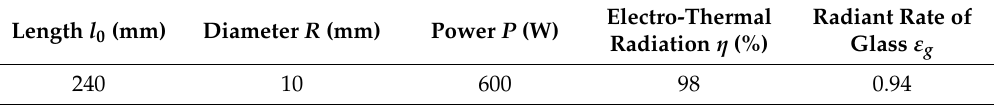
Table 1. Parameters of carbon fiber radiator and curtain wall glass.